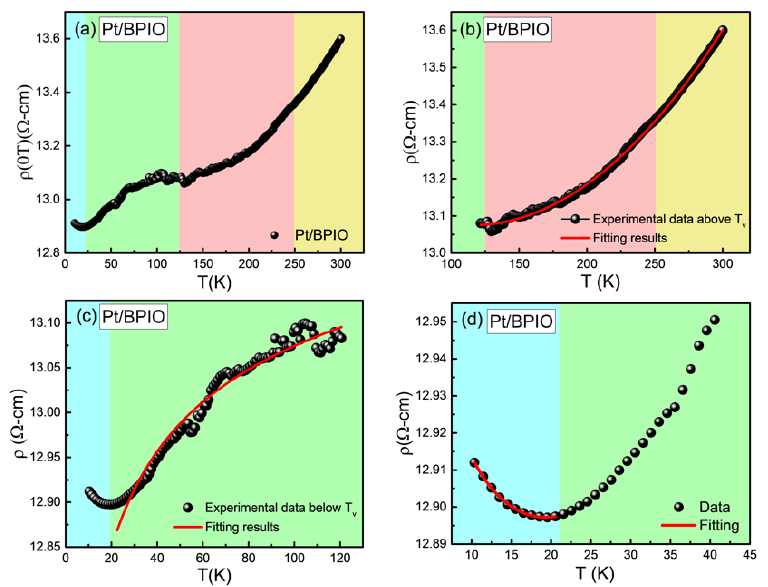
Figure 4. Zero field resistivity measured at temperatures between 10 and 300 K for ( a ) Pt/BPIO. Curves fitted for temperatures ( b ) above and ( c ) below the T V in Pt/BPIO and ( d ) the minimum resistivity behavior noted below 20 K.